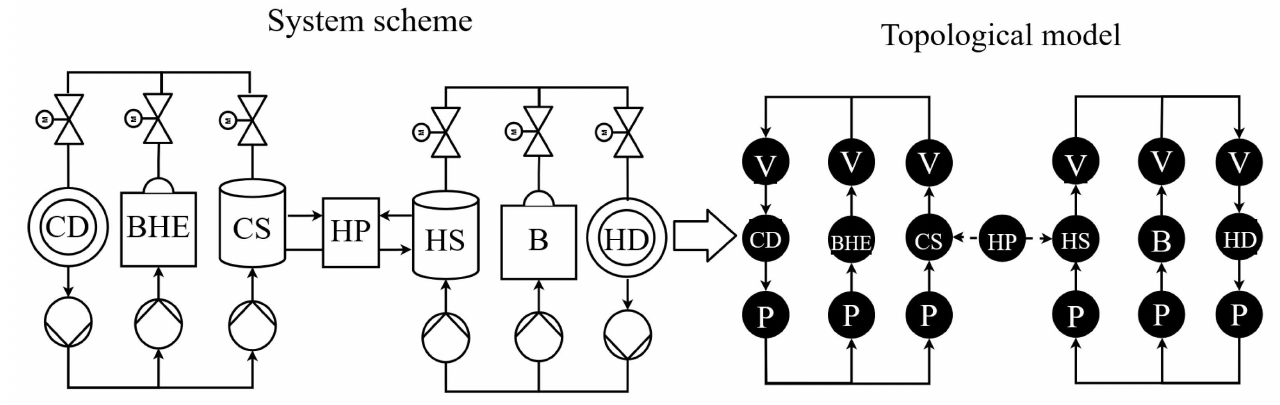
Figure 5. Scheme and topological model of an energy supply system. CD: cold demand; BHE: borehole-heat-exchanger field; CS: cold storage; HP: heat pump; HS: heat storage; B: boiler; HD: heat demand; V: valve; P: pump.